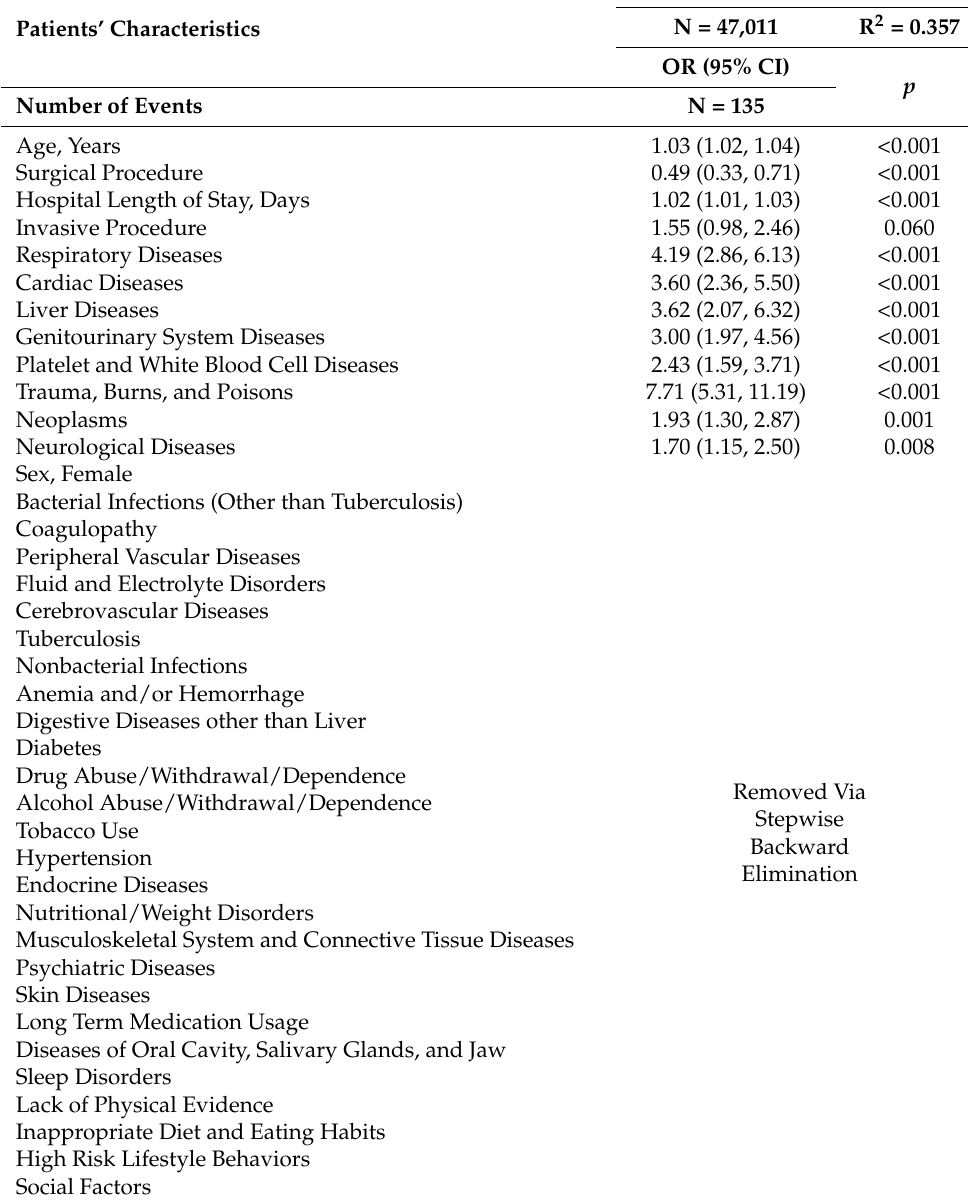
Table 4. Backward logistic regression analysis to evaluate the associations between mortality and different risk factors in patients emergently admitted with a primary diagnosis of abscess of anal and rectal regions (NIS 2005–2014). Mortality was the dependent